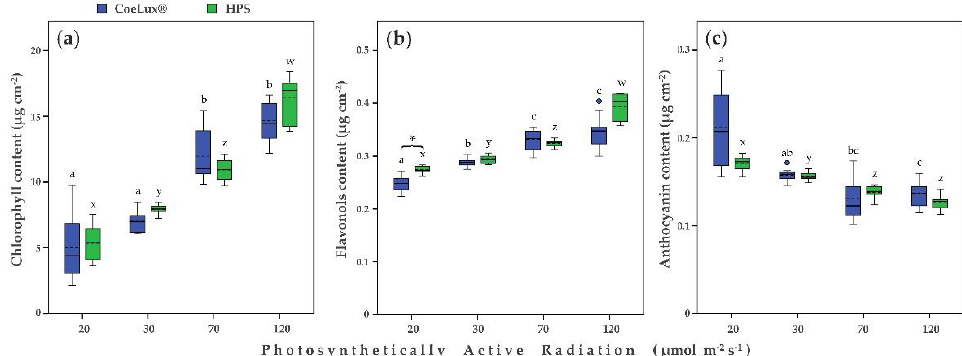
Figure 4. ( a ) Chlorophyll content ( µ g cm − 2 ), ( b ) flavonols content ( µ g cm − 2 ), and ( c ) anthocyanin content ( µ g cm − 2 ) for different light intensities. Blue and green bars indicate data of plants grown under the CoeLux ® and the HPS light types, respectively. Black asterisks indicate statistically significant differences ( p < 0.05) between plants grown under the CoeLux ® and the HPS light type within the same light intensity. Letters indicate statistically significant differences ( p < 0.05) between plants grown under different light intensities within the same light type. Vertical boxes represent approximately 50% of the observations and lines extending from each box are the upper and lower 25% of the distribution. Within each box, the solid horizontal line is the median value, whereas the dotted horizontal line is the mean.